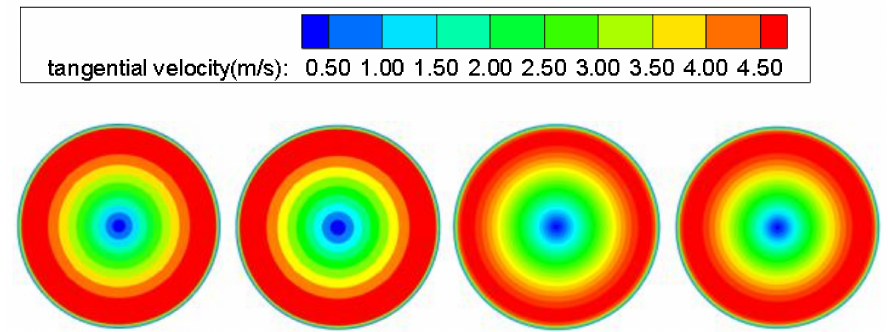
Figure 10. Distribution cloud of tangential velocity in different cross sections.